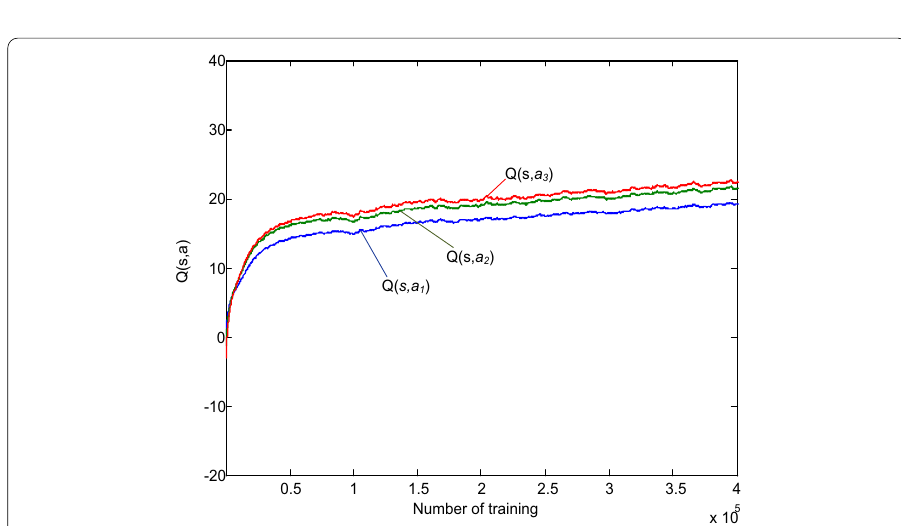
Fig. 9 Value function convergence. This figure gives the convergence of the action value function where Q( s , a 1 ), Q( s , a 2 ) and Q( s , a 3 ), respectively, correspond to the action value functions corresponding to the three different actions by the user in the same state s . As shown in the figure, the convergence of the action